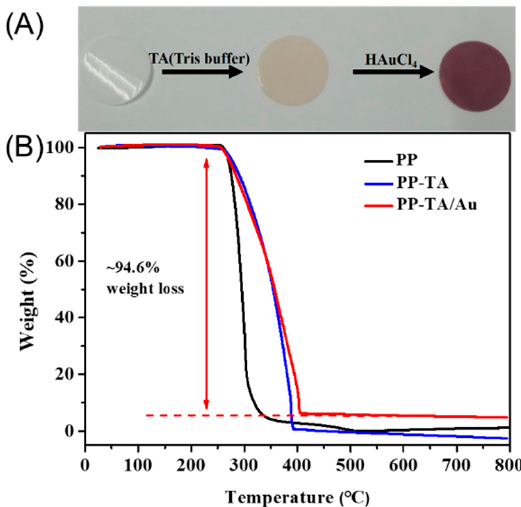
Figure 2. ( A ) picture of pristine polypropylene (PP) separator (left), PP-TA separator (middle) and PP-TA / Au separator (right). ( B ) TG curve of PP separator, PP-TA separator and PP-TA / Au separator.